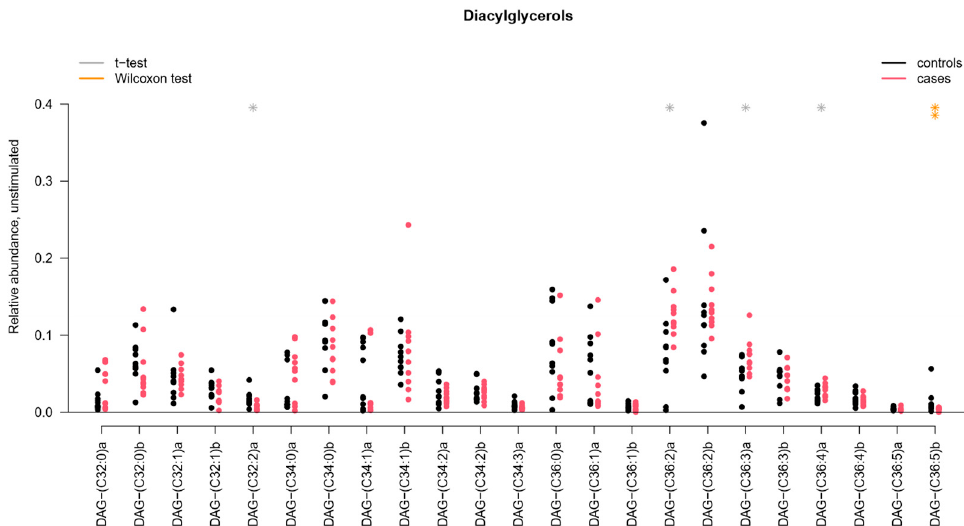
Figure 2. Distribution of individual diacylglycerols (DAG) in unstimulated whole saliva. * p < 0.05; ** p < 0.01; pSS: primary Sjögren’s syndrome. DAG(C32:2)a, DAG(C36:2)a, DAG(C36:3)a, DAG(C36:4)a, and DAG(C36:5)b showed a significant difference between pSS patients and controls.